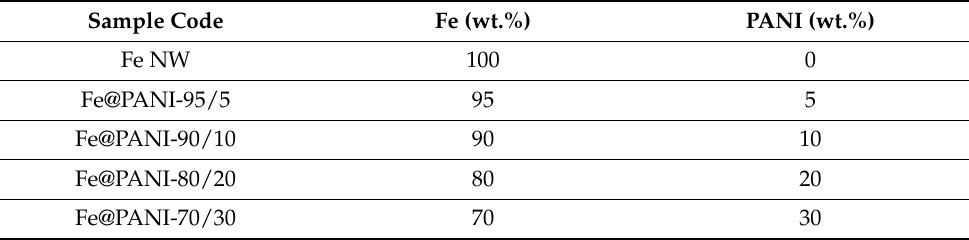
Table 1. Summary of the sample codes for the Fe@PANI nanowires. Sample